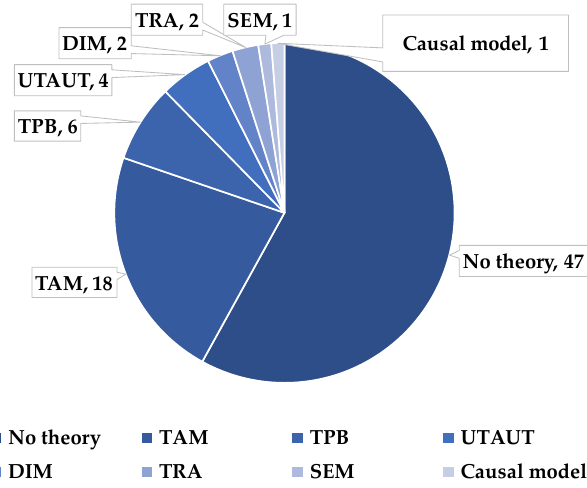
Figure 1. A summary of theoretical models in the literature on autonomous acceptance .